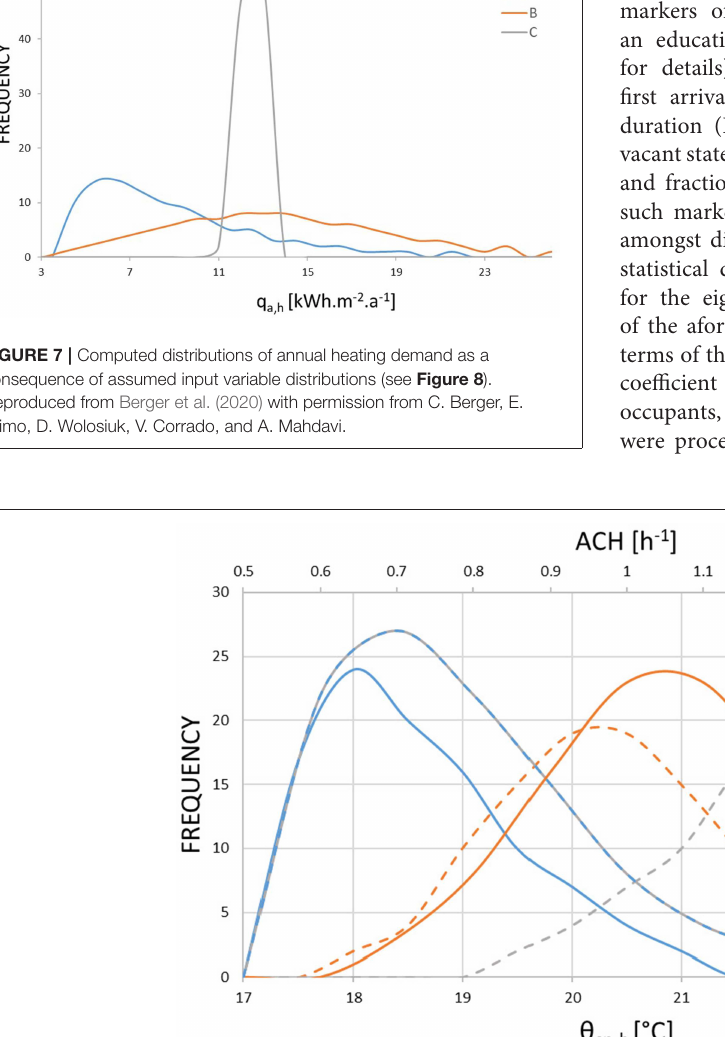
Frontiers in Energy Research |